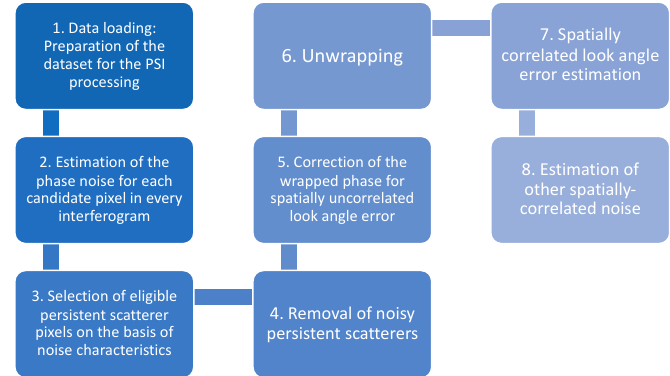
Figure 6. Work fl ow of TRAIN processing. Figure 6. Workflow of TRAIN